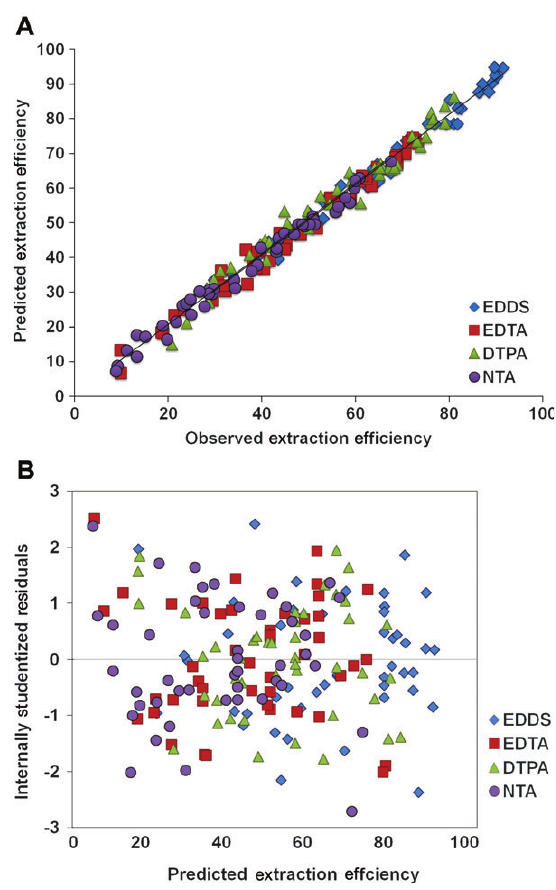
Figure 3 ( A) Graphical representation of comparative analysis of observed and predicted (%) Ni extraction efficiency of different chelating agents and (B) plot of internally studentized residuals vs. predicted